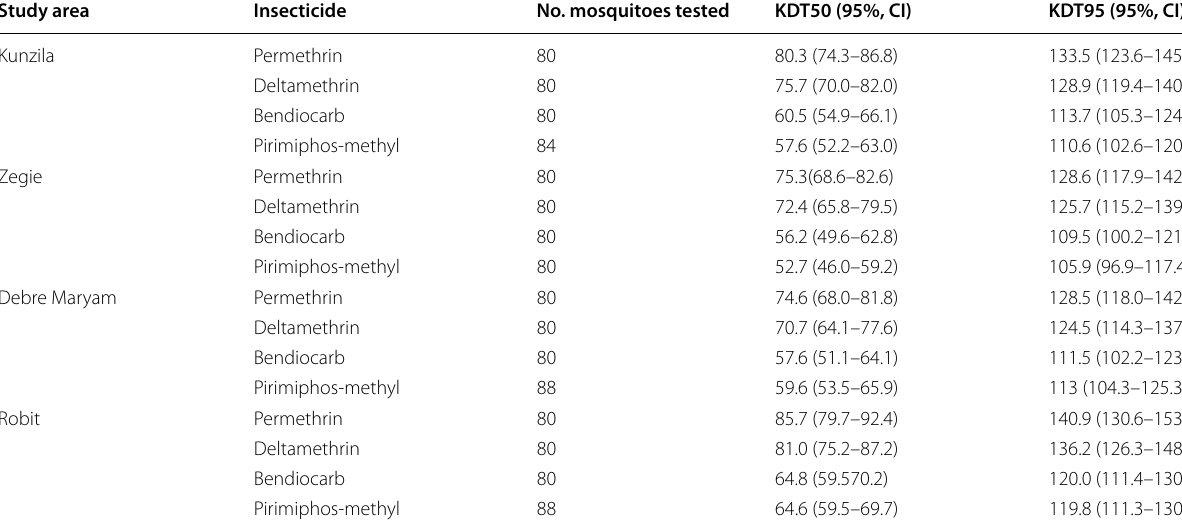
Table 3 Knockdown times (minutes) (KDT50 and KDT95) of An. gambiae s.l. in different insecticides across the study areas Study